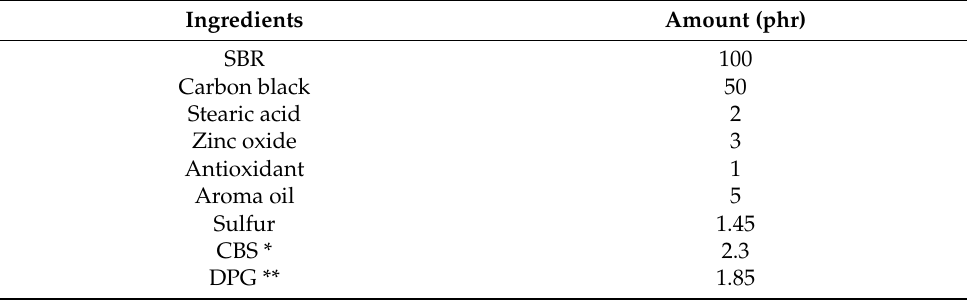
Table 1. Recipe of SBR